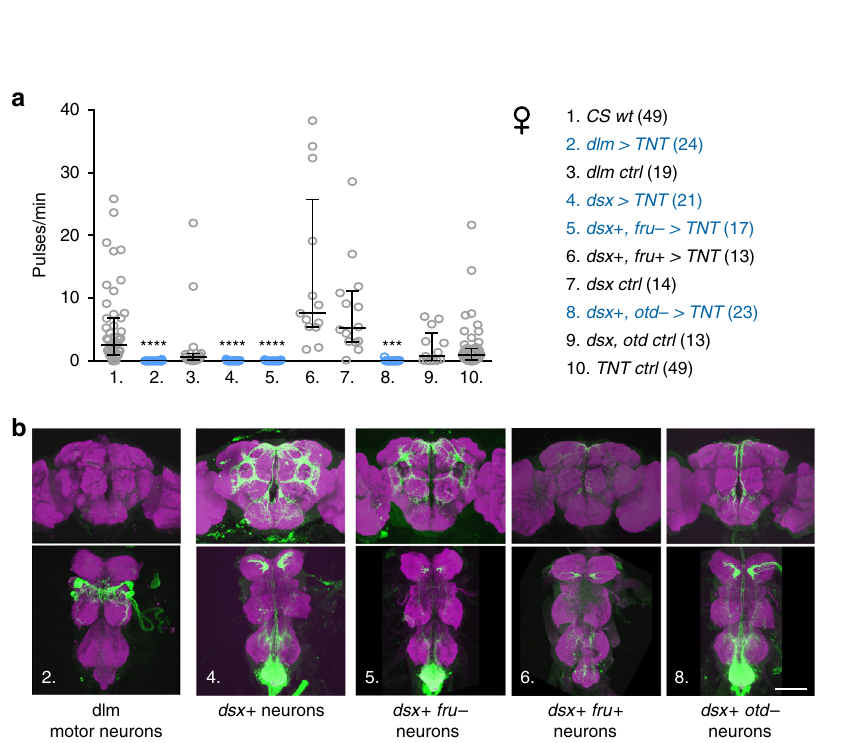
Fig. 2 Neuronal control of female copulation song. a Song pulses per minute copulation (with CS wt males) for females with different subsets of neurons silenced with tetanus toxin (TNT) and controls. For full genotypes, see Methods. Signi fi cant reduction of female song is indicated in cyan. Each data point represents one fl y, n is indicated after the genotypes, error bars indicate median and interquartile range, **** p < 0.0001, *** p = 0.0003, Kruskal – Wallis test with Dunn ’ s multiple comparison (two-sided). b Nervous system expression pattern of selected genotypes from a , Gfp in neurons in green, neuropil anti- bruchpilot staining in magenta. A micrograph of one representative tissue (out of 5 or more samples per genotype with the same expression pattern) is shown. Scale bar, 100 µ m. Source data are provided as a Source data fi le.